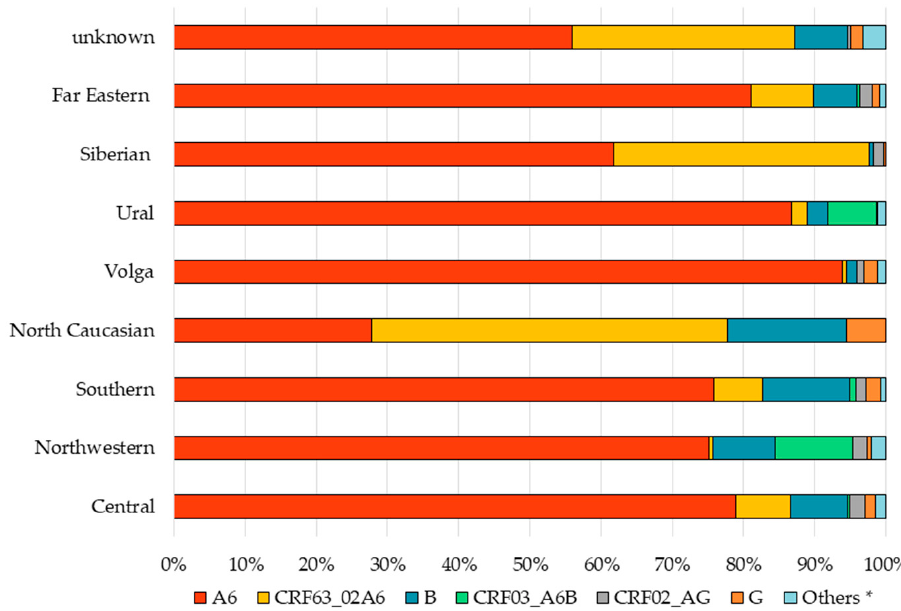
Figure 1. Prevalence of HIV-1 genetic variants in the FDs of Russia. * Others (other HIV-1 genetic Table 2. Prevalence of HIV-1 genetic variants among the transmission risk